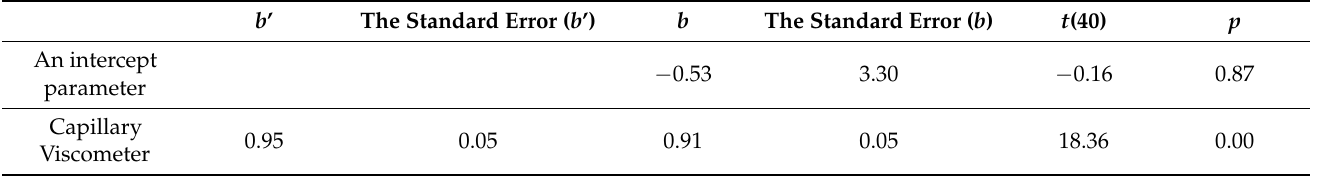
Table 5. The estimation results for the measurements carried out with the Microchannel viscometer and Capillary viscometer. b ’ The Standard Error ( b ’) b The Standard Error ( b ) An intercept parameter Capillary